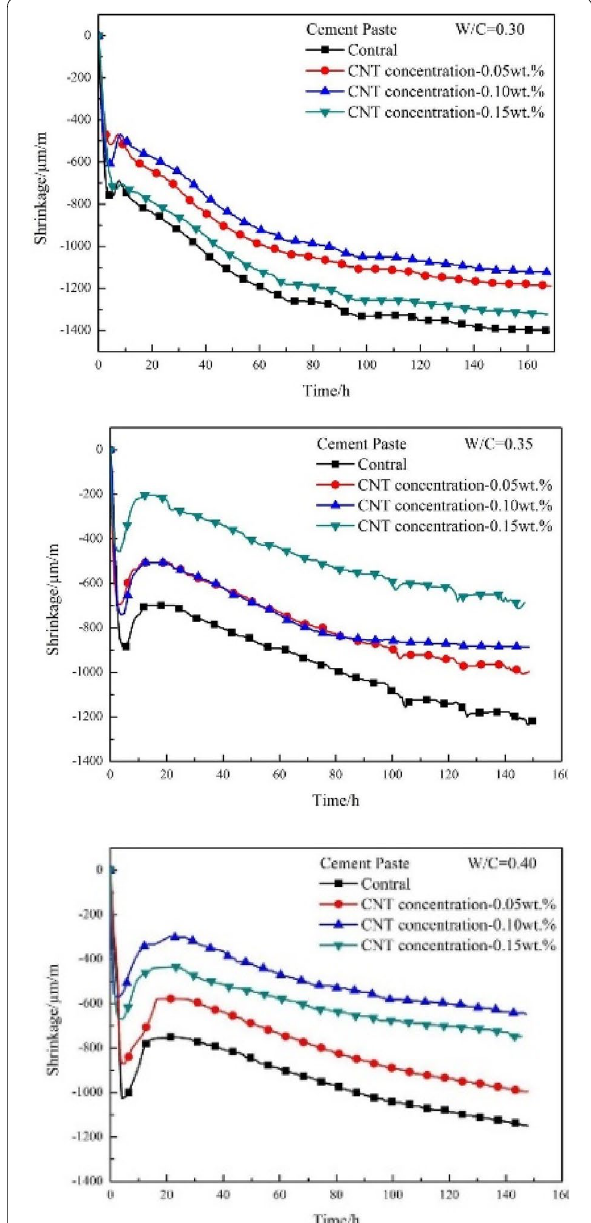
Fig. 4 Shrinkage curve of cement paste with different water to cement ratios (W/C =